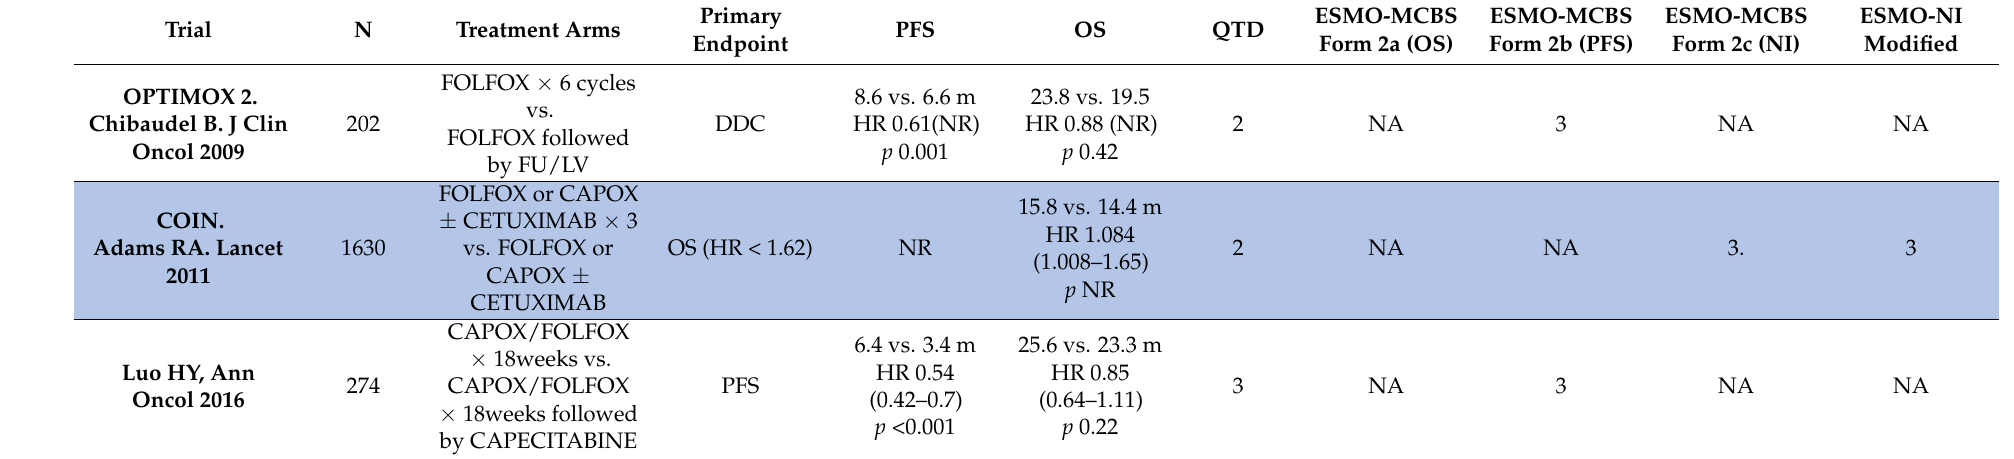
Table 7. Continuous vs. intermittent CT